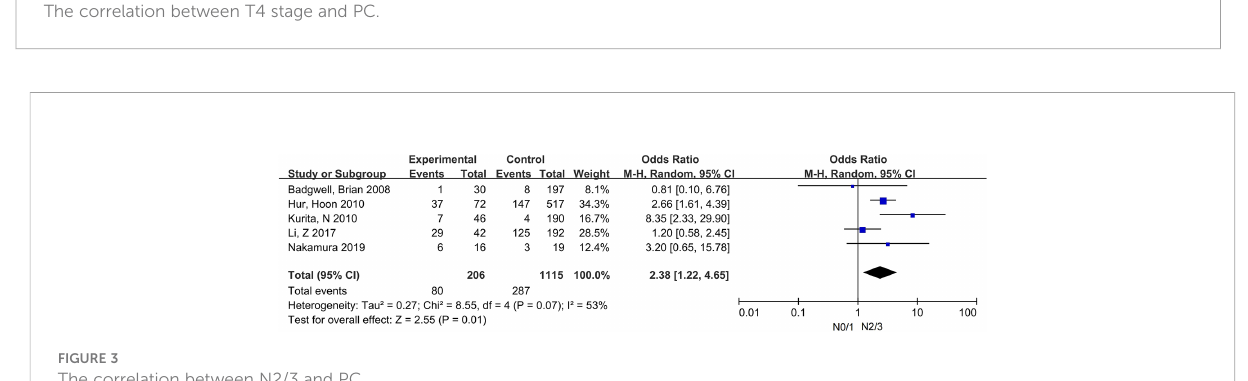
FIGURE 3 The correlation between N2/3 and